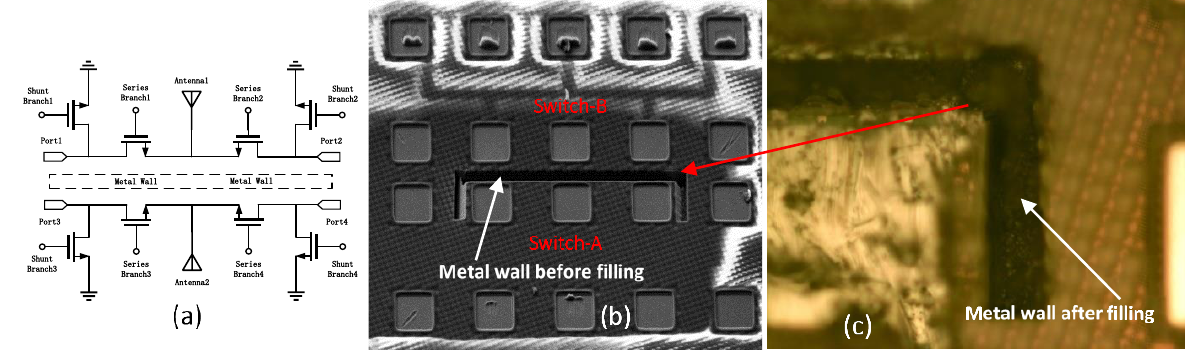
Figure 12. In-BEOL metal wall structure in an SPDT RF switch IC designed in a 45 nm SOI CMOS: ( a ) SPDT schematic, ( b ) partial metal wall trench etched by FIB, and ( c ) zoom in of the silver-filled metal wall structure [35].